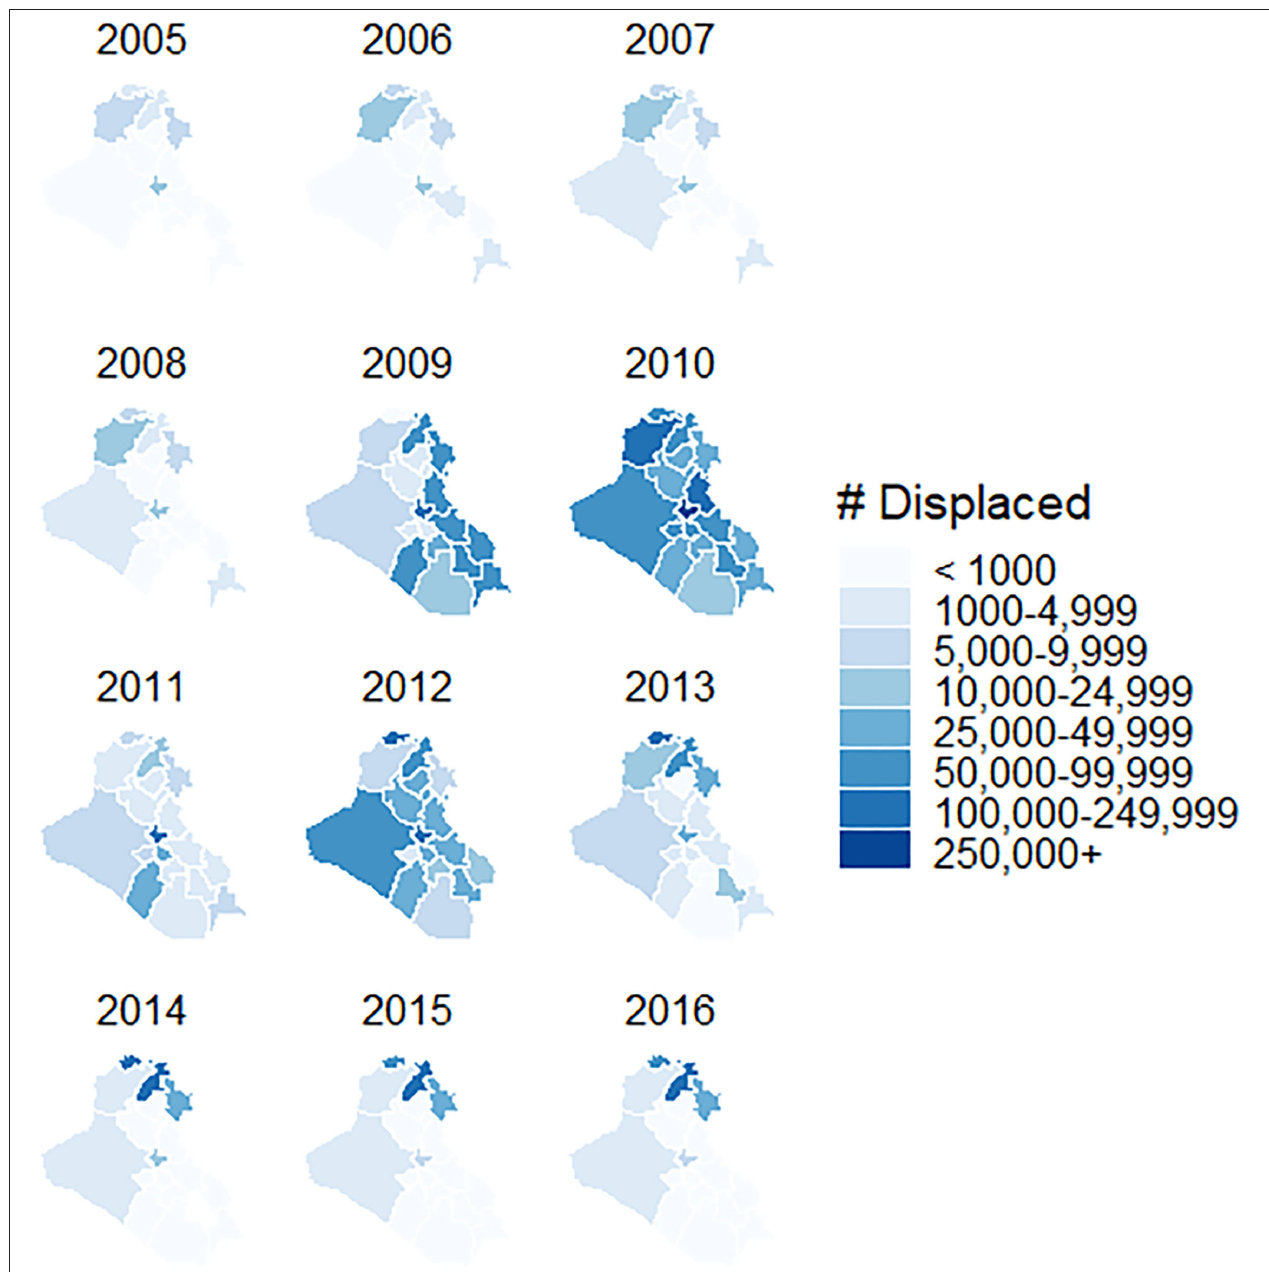
FIGURE 3 | Total number of persons of concern in Iraq by governorate,